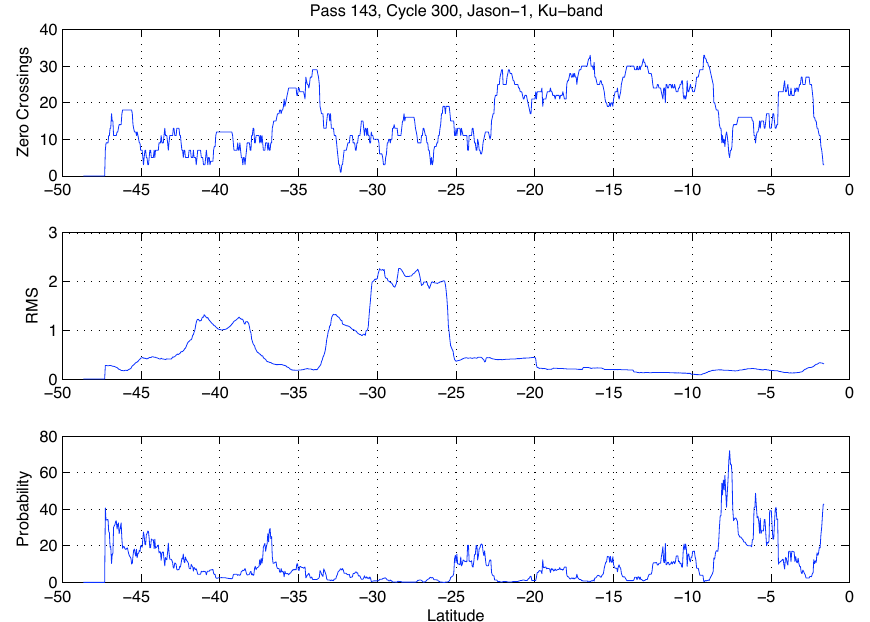
Fig. 10. Statistical randomization tests using a “sliding window” for pass 143 of Jason-1 cycle 300. A randomization test is conducted for every 3.2 ◦ window and the statistical significance is computed to test the hypothesis that the surface roughness variations with and without the tsunami present are not significantly different. The x-axis values represent the center point of each window.